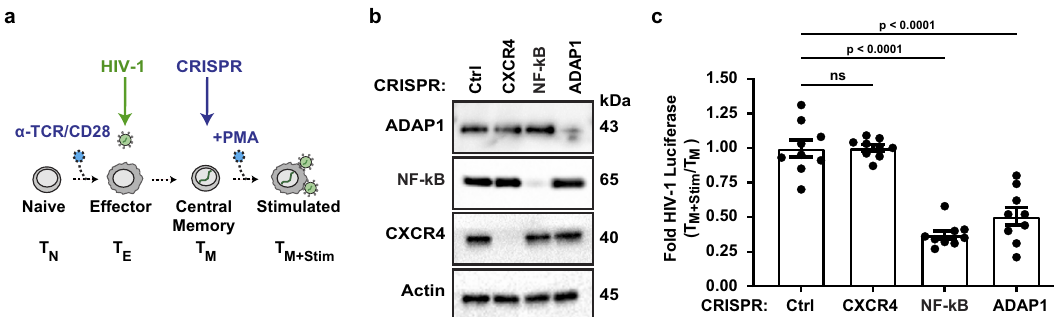
Fig. 3 Loss of ADAP1 hinders latent HIV-1 reactivation ex vivo. a Schematic of generation of ex vivo model of HIV-1 latency and CRISPR-Cas9 engineered cells HIV-Ctrl CRISPR , HIV-CXCR4 CRISPR , HIV-NF- κ B CRISPR (p65 subunit), and HIV-ADAP1 CRISPR . b Representative western blot analysis of CRISPR-Cas9- mediated knockout ef fi ciency (repeated in two other donors with similar results). c Luciferase analysis of HIV-Ctrl CRISPR , HIV-CXCR4 CRISPR , HIV- NF κ B CRISPR , and HIV-ADAP1 CRISPR T M stimulated for 48 h with PMA. Data represents mean ± s.d. fold change of three donors ( n = 3 each), HIV-Ctrl CRISPR normalized to 1 representing max activation. (one-way ANOVA followed by Dunnett ’ s test for multiple comparison to Ctrl CRISPR ). ns not signi fi cant. Source data are provided as a Source Data